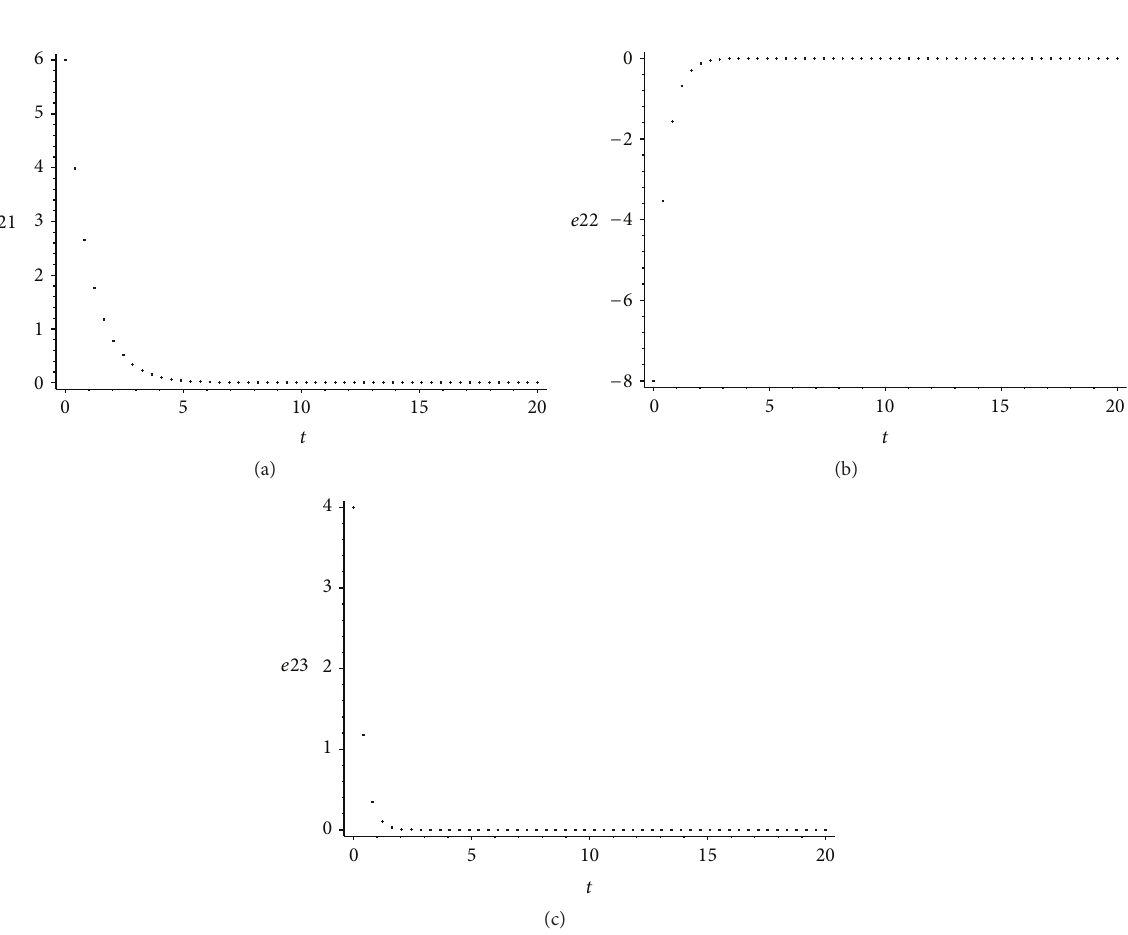
Figure 3: The chaos attractor of (14) system (a) and Chee-Lee system (b).